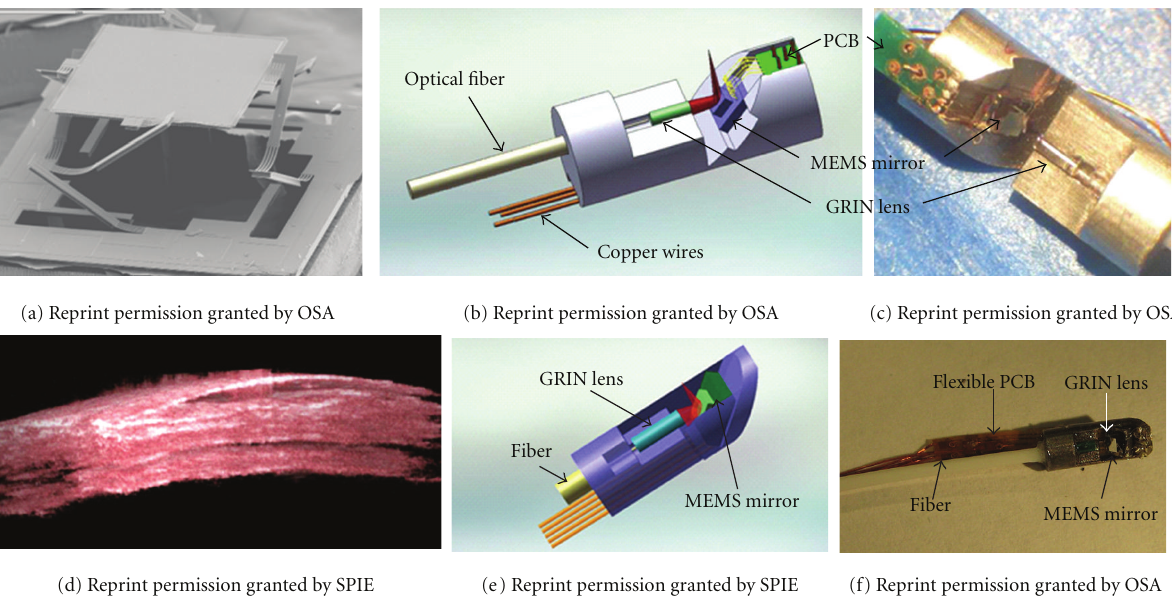
Figure 10: Electrothermal MEMS OCT reported by Sun et al. (a) SEM of electrothermal MEMS mirror, (b) 5mm probe 3D model, (c) 5mm assembled probe, (d) 2.7 mm probe 3D model, (d) 2.7mm assembled probe, (f) 3D OCT image of mouse ear obtained by 5mm probe shown in (b) and